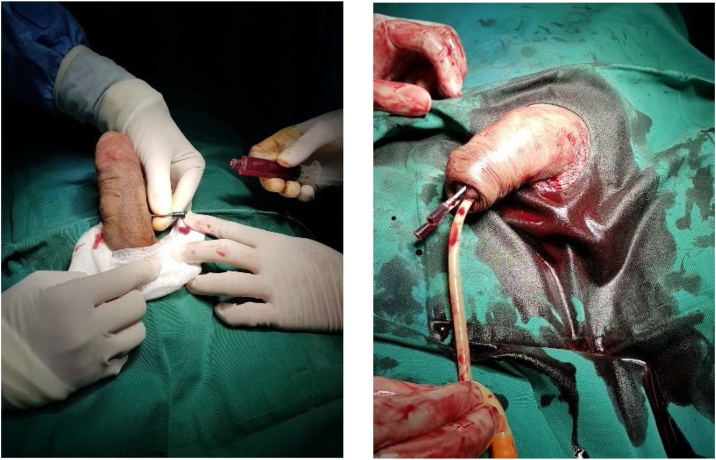
Intra Operative.